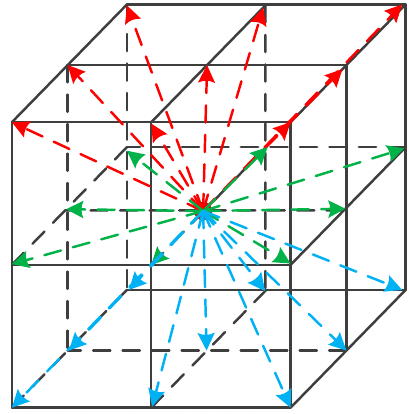
Figure 2. 26 neighborhood linked matrix.